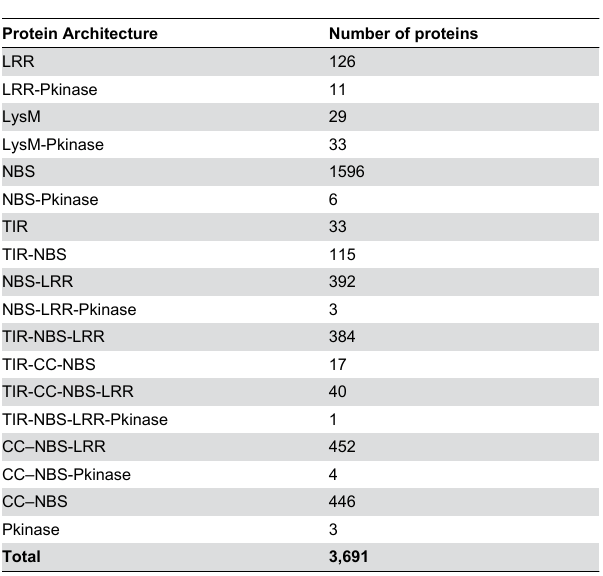
Table 2. Protein architecture of plant resistance genes identified in a plant protein database created from databases at NCBI and SGN.